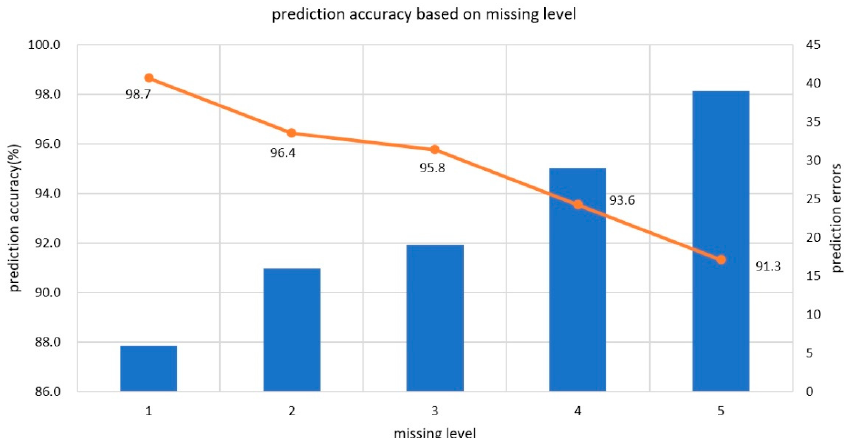
Figure 7. The prediction accuracy based on 5 missing levels.